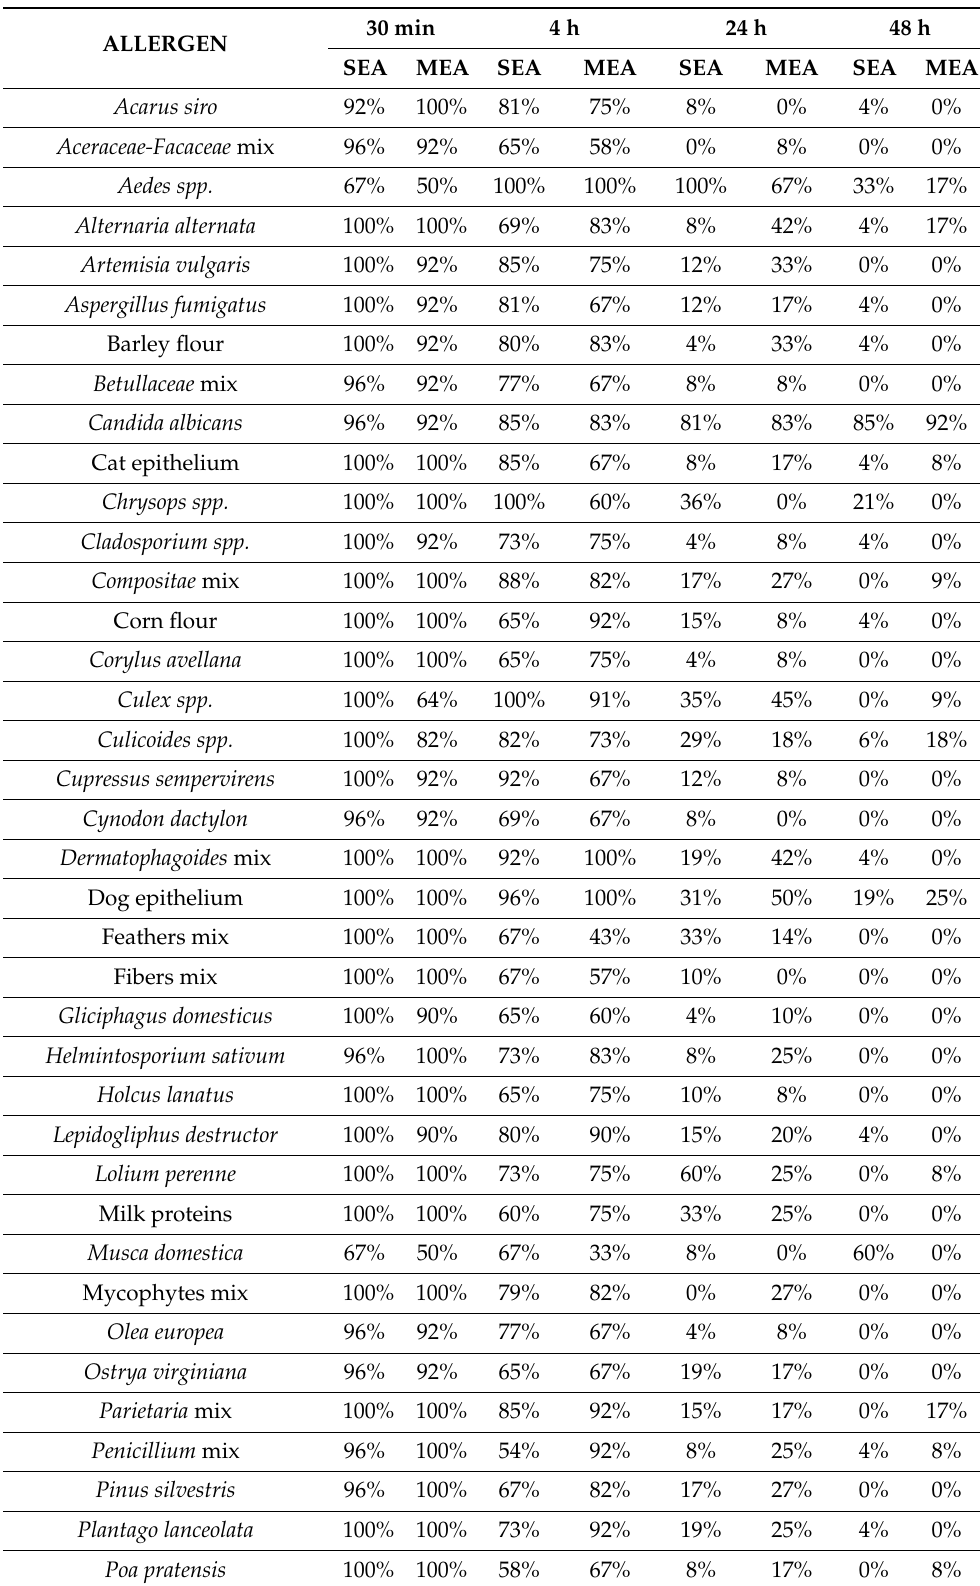
Table 2. Frequencies of positive reactions to each allergen at different evaluation times in the SEA and MEA groups. 30 min 4 h 24 h 48 h ALLERGEN SEA MEA SEA MEA SEA MEA SEA MEA Acarus siro 92% 100% 81% 75% 8% 0% 4% 0% Aceraceae-Facaceae mix 96% 92% 65% Aedes spp. 67% 50% 100% Alternaria alternata 100% 100% 69% Artemisia vulgaris